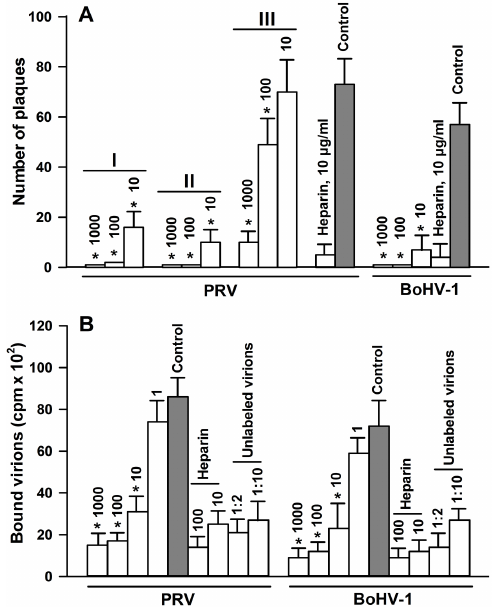
Figure 4. Effects of the 2,5-DHBA–gelatin conjugate on viral plaque formation ( A ) and on the attachment of radiolabeled PRV and BoHV-1 virions ( B ). ( A ) PRV was added to cells either simultaneously with the conjugate (I), or the conjugate was pre-incubated with cells for 1 h at 4 ˝ C followed by the addition of PRV without the washing (II) or after the washing of cells with cold PBS (III). BoHV-1 was added simultaneously with the conjugate. The cells were incubated for 1 h at 4 ˝ C and washed after which viral plaques were detected after incubation for 36–48 h at 37 ˝ C; ( B ) Cell monolayers in 96-well plates were chilled and washed after which a constant amount of [ 35 S ]-labelled PRV and BoHV-1 virions (100,000-300,000 cpm/well) was incubated for 2 h at 4 ˝ C in the presence of increasing concentrations of 2,5-DHBA–gelatin and heparin. To assess the specificity of binding of virions to cells, chilled and washed cells were incubated at 4 ˝ C for 1 h with purified unlabeledvirions at different dilutions followed by incubation with radiolabeled virions (100,000–300,000 cpm/well) for 2 h at 4 ˝ C. 2,5-DHBA–gelatin and heparin concentrations ( µ g/mL) and unlabelled purified virion dilutions are indicated above the bars. The amount of cell-bound radiolabeled virions was determined as described in Materials and Methods. Each value is the mean ˘ SD of three to four repeats. Asterisks indicate the statistical difference from the control: * p <